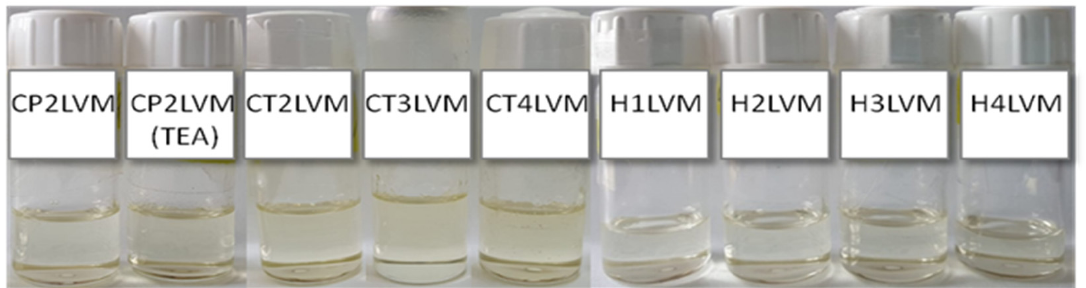
Figure 2. Visual appearance of gel microemulsions used as Curcumin delivery system.